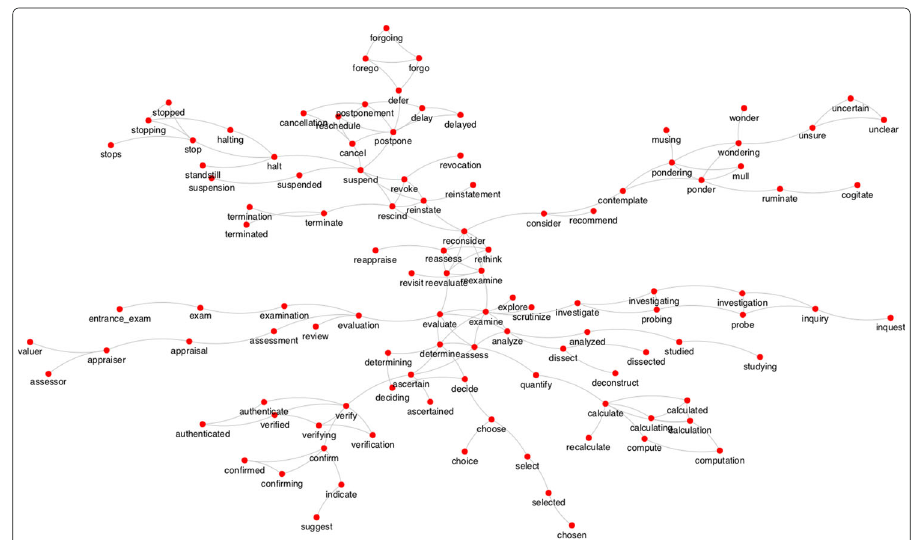
Fig. 2 One of the connected components in the network constructed based on word2vec embedding of Google News containing words form WordNet sliced at 0.6 cosine similarity threshold. The component contains 109 words and 152 edges